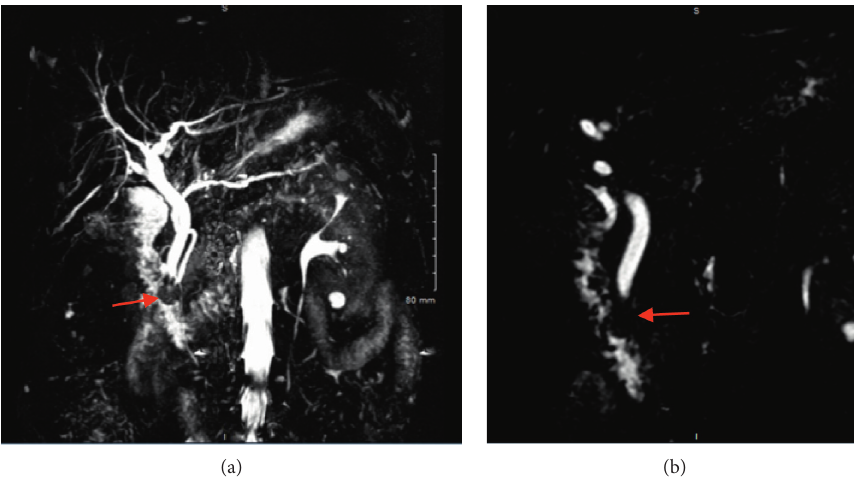
Figure 2: MRI/MRCP showing CBD dilatation without choledocholithiasis as well as papillary stenosis.